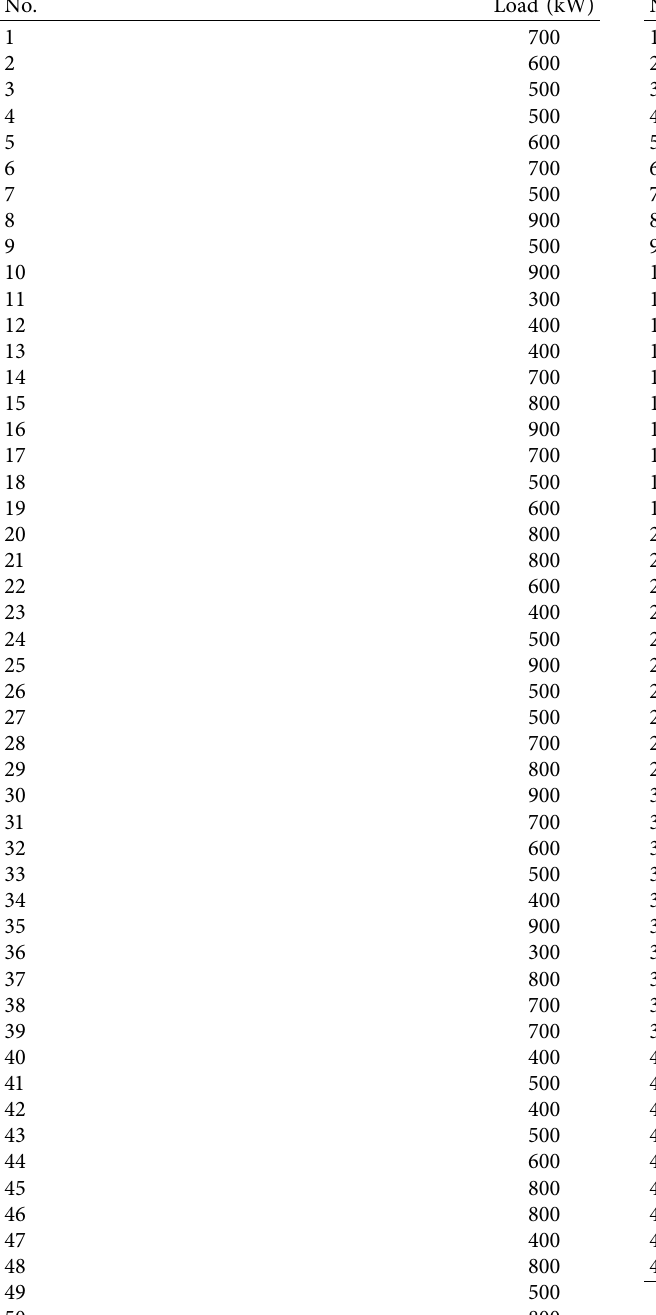
Table 2: Specification of load nodes in MV part. Table 3: Specification of load nodes in LV